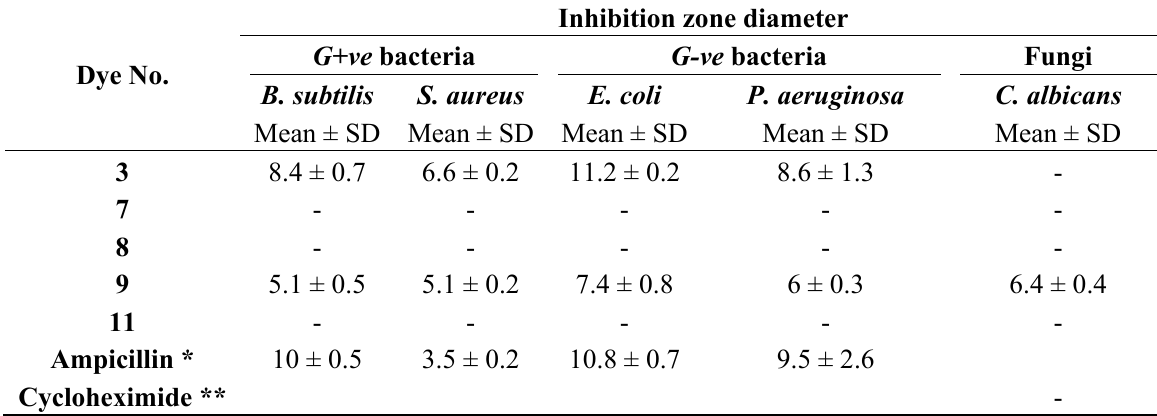
Table 3. Diameter of the zones of inhibition of the tested disperse dyes against Gram positive, Gram negative bacteria and yeast.